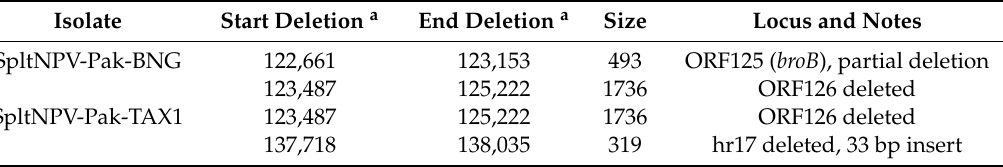
Table 1. Large deletions in the Splt-Pak-BNG and Splt-Pak-TAX1 isolates. Isolate Start Deletion a End Deletion a Size Locus and Notes